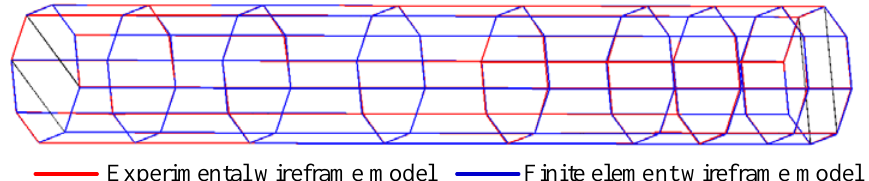
Figure 11. Wireframe models for EMA vs. FMA.